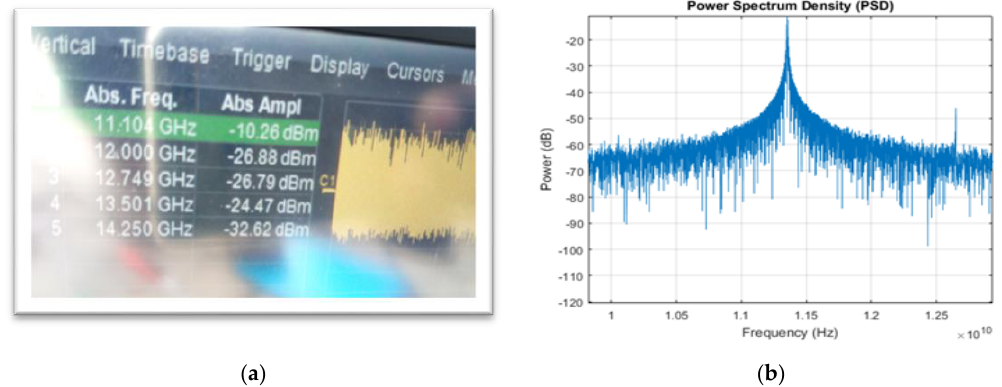
Figure 5. FSR receiver block diagram to receive direct DVB-S signal and signal scattered by the drone.